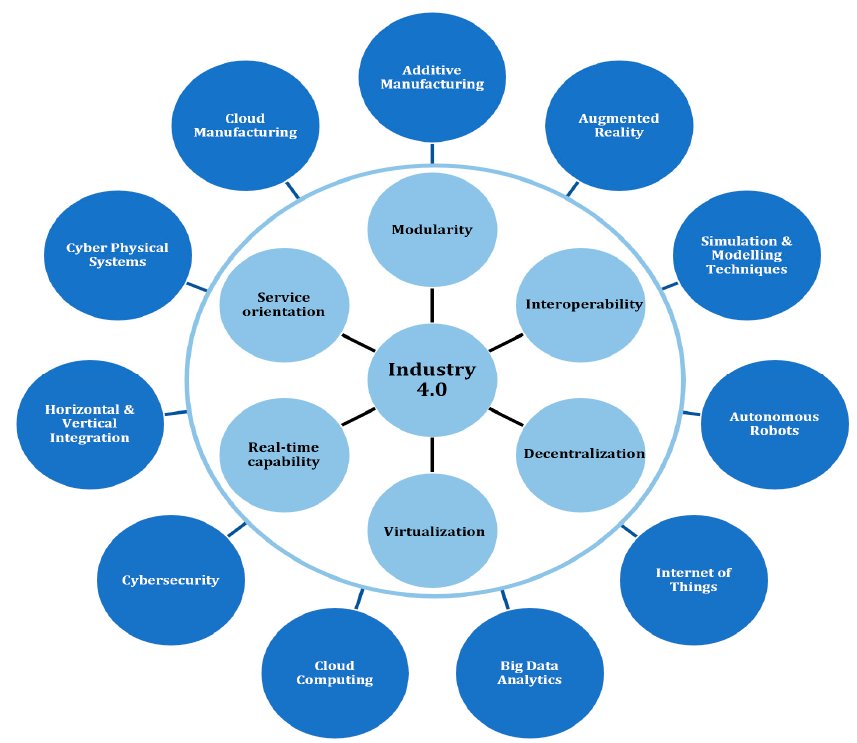
Figure 1. Industry 4.0 technology trends and design principles.